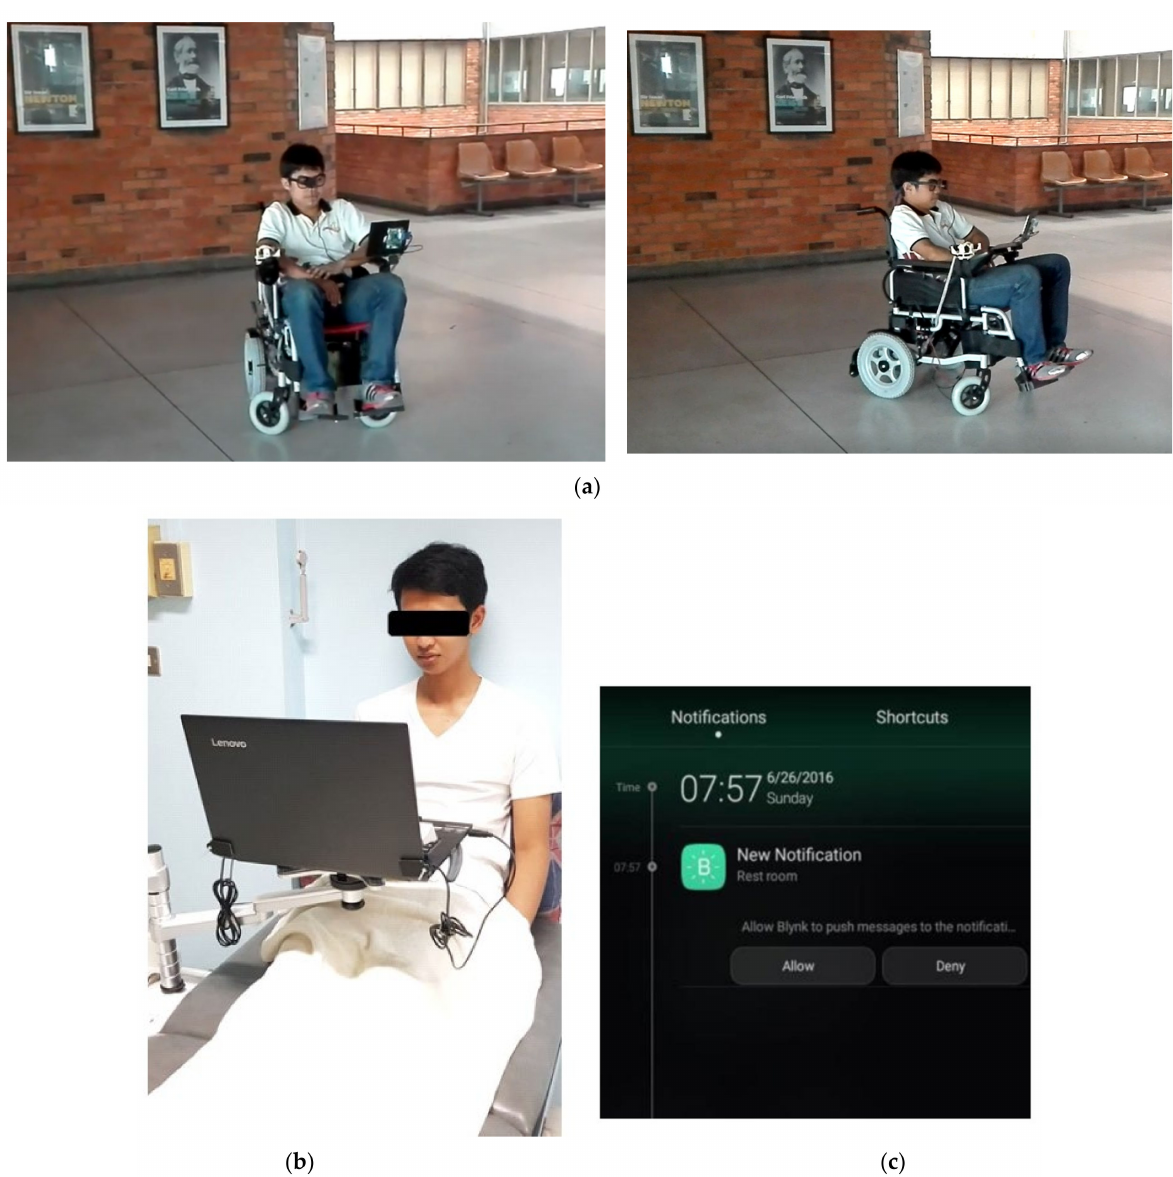
Figure 14. Operational test for ( a ) mobile assistive system (eye-controlled wheelchair); ( b ) stationary assistive system; ( c ) nurse calling